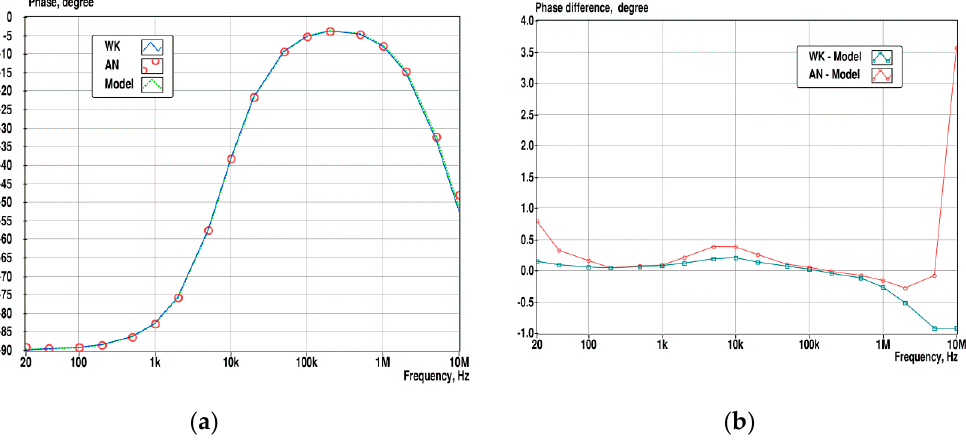
Figure A5. Impedance phases ( a ) of the SUT1, measured with the Wayne Kerr analyzer (WK), the developed analyzer (AN), and calculated from a computer model at the nominal values of its components. Deviations of phase values ( b ), measured with WK and AN, from the modeled results.